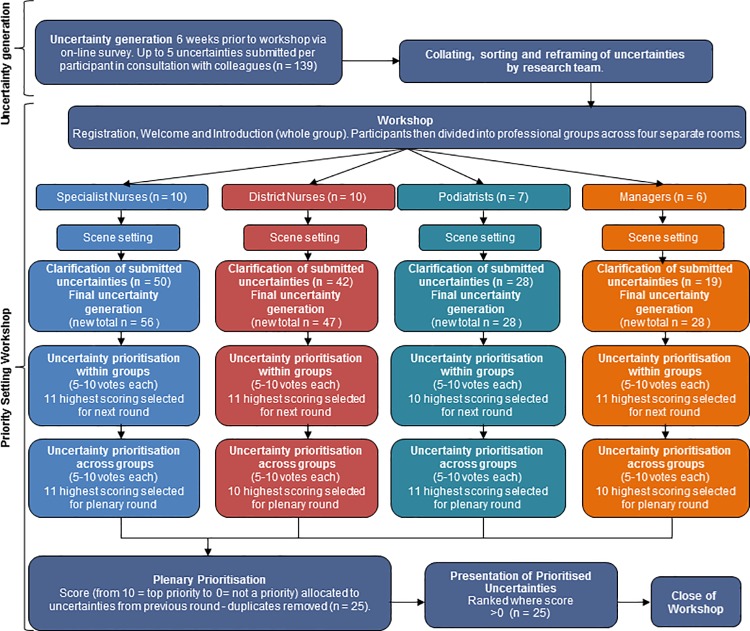
Methods flow chart.